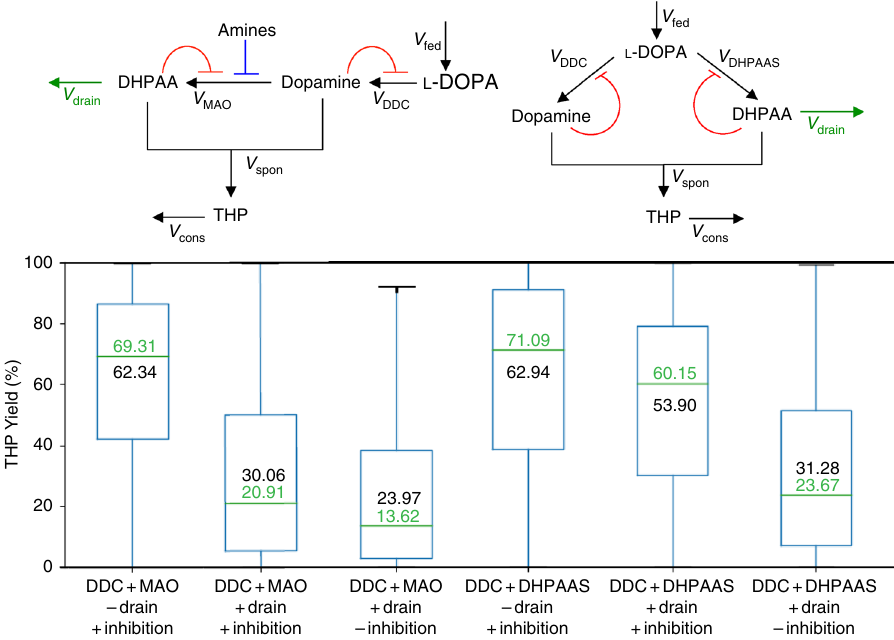
Fig. 2 Predicted THP yields from DHPAAS- and MAO-mediated pathways. Conversion of L -DOPA to THP was simulated with and without DHPAA drain (green arrows), and also with and without product feedback inhibition (red fl at-headed curves). The blue fl at-headed line shows MAO inhibition by amines included in all MAO models. Green center lines show the median values ( fi ftieth percentile or second quartile), and the blue boxes contain the twenty- fi fth percentile ( fi rst quartile) to seventy- fi fth percentile (third quartile) of each dataset. The black whiskers show minimum and maximum values of each dataset. Median predicted THP yields are listed in green and mean predicted THP yields are listed in black within each box. All statistics were derived from n = 10,000 independent Monte – Carlo